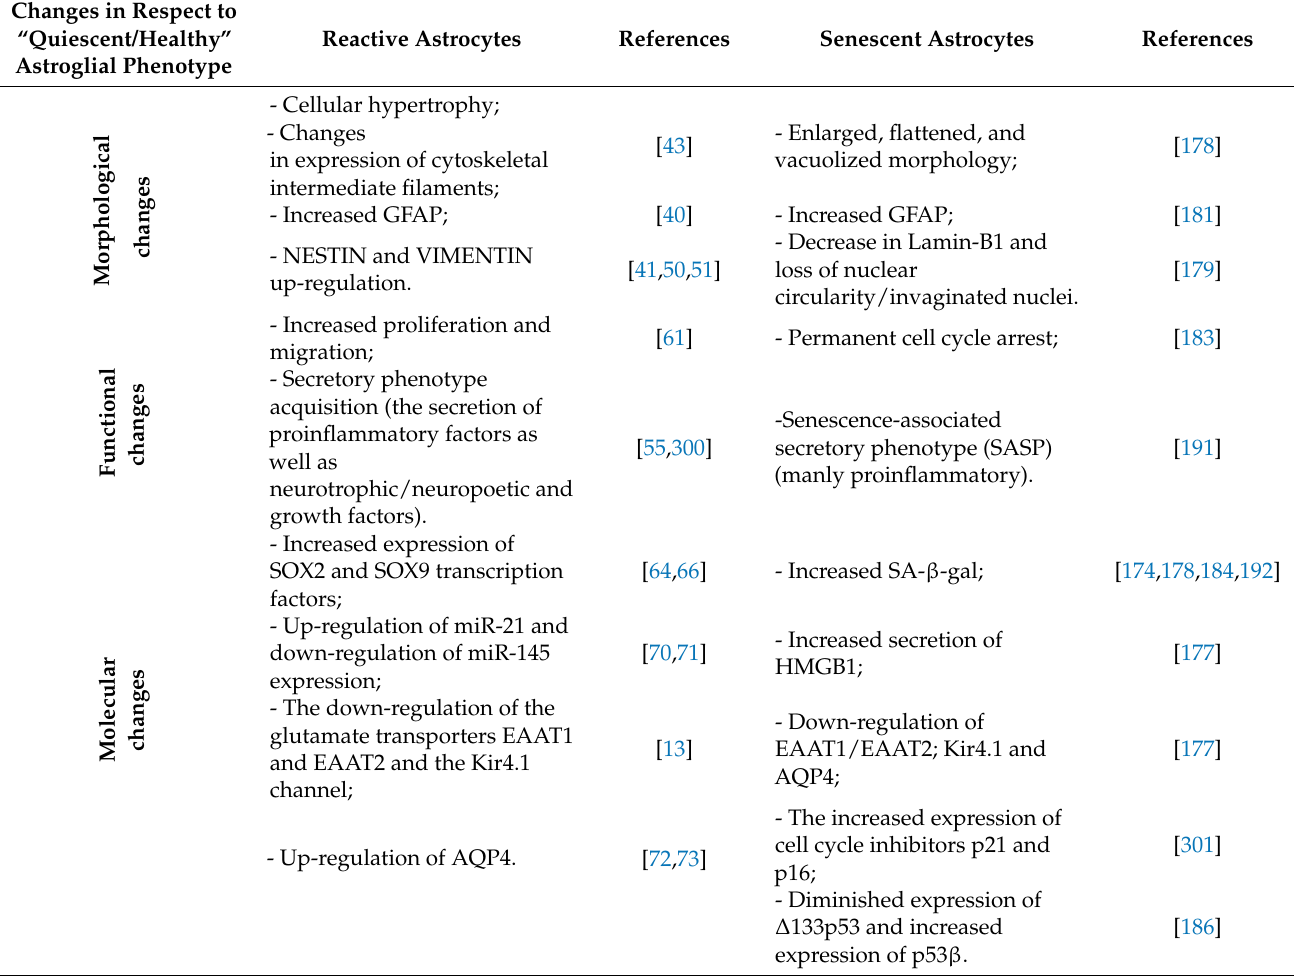
Table 1. Summarizing similarities and difference between reactive and senescent